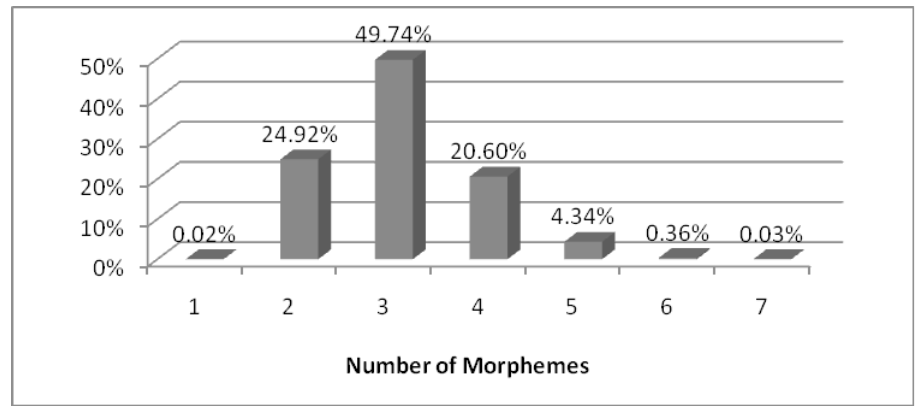
Figure 3. Percentage of Adjectives with a Different Number of Morphemes Uni-morphemic adjectives as nouns are uninflected international words, e.g. makro, mikro, mezo (the R model, 0.02% of all